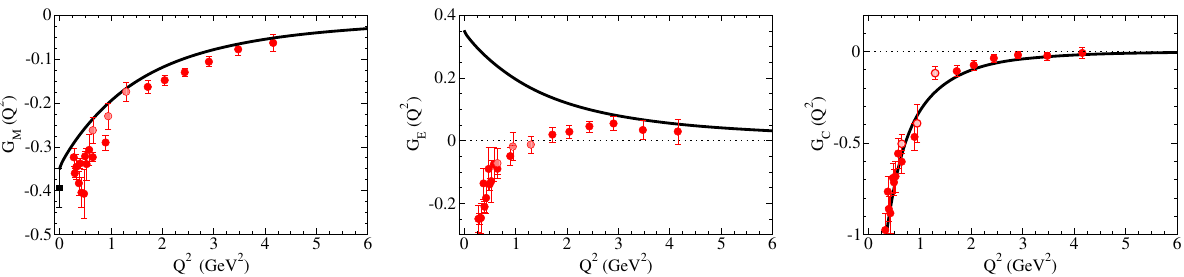
Figure 4. γ ∗ N → N (1520) transition form factors. The solid line is the result of the semirelativistic approximation. Data from JLab (circles) [6, 45, 47] and PDG (square) [6].